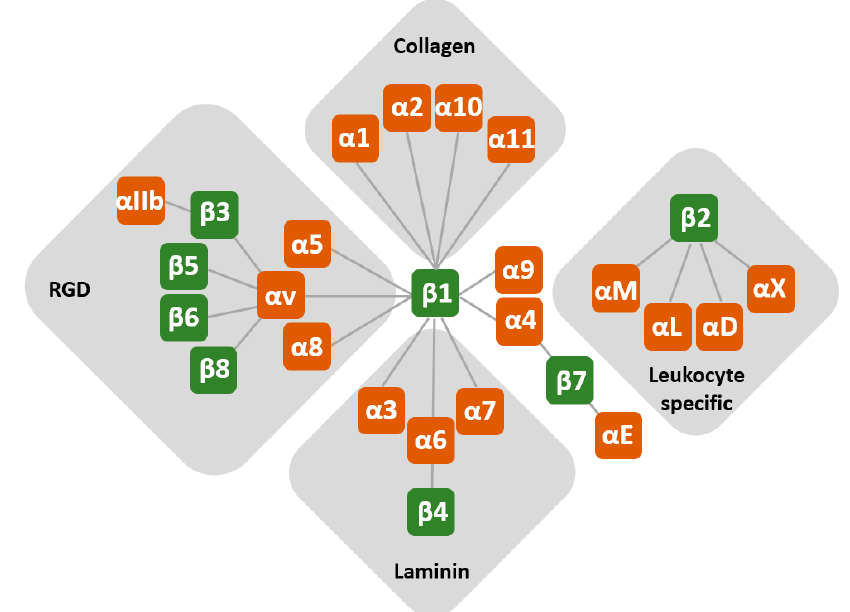
Figure 1. Pairing of integrin subunits. Integrins are transmembrane proteins that mediate cell adhesion to extracellular matrix proteins or cell surface counter-receptors. They are expressed on the cell surface as heterodimers consisting of α and β subunits. To date, 18 di ff erent α and 8 β subunits have been identified, which give rise to 24 heterodimers. Di ff erent integrins bind di ff erent ECM proteins and / or cell surface molecules, which have a specific spatial and temporal distribution pattern in a given tissue. Integrins are separated into subsets of closely related subunits.